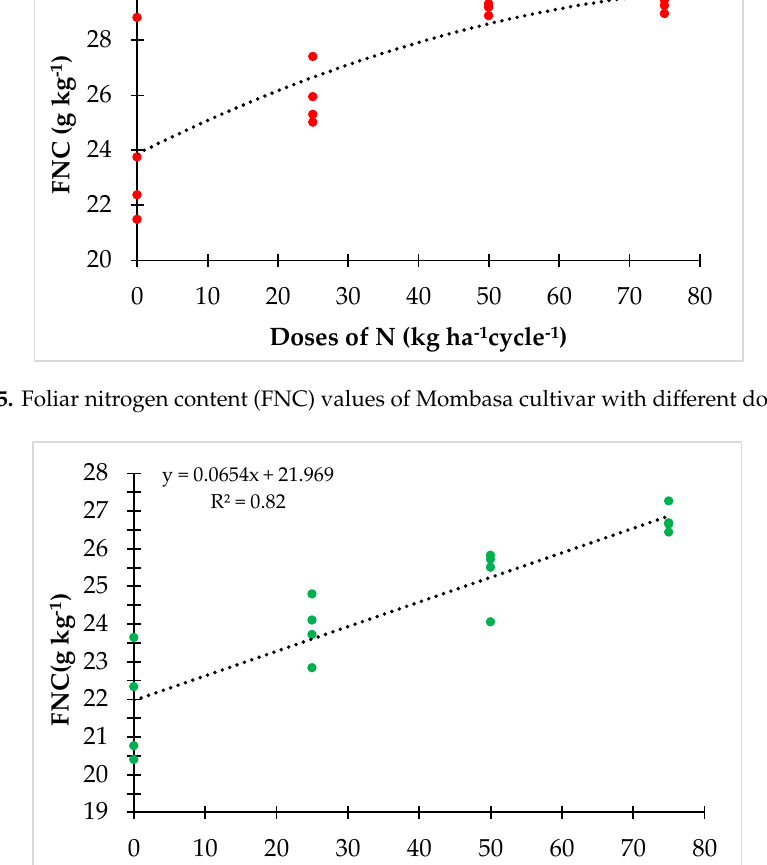
Table 5. Results of the best bands obtained from the Sentinel-2 satellite for the different vegetation indices, as a function of the biophysical parameters studied (productivity, FNC, height and leaf area index (LAI)) for Mombasa and Marandu dataset. The best results are shown shaded.